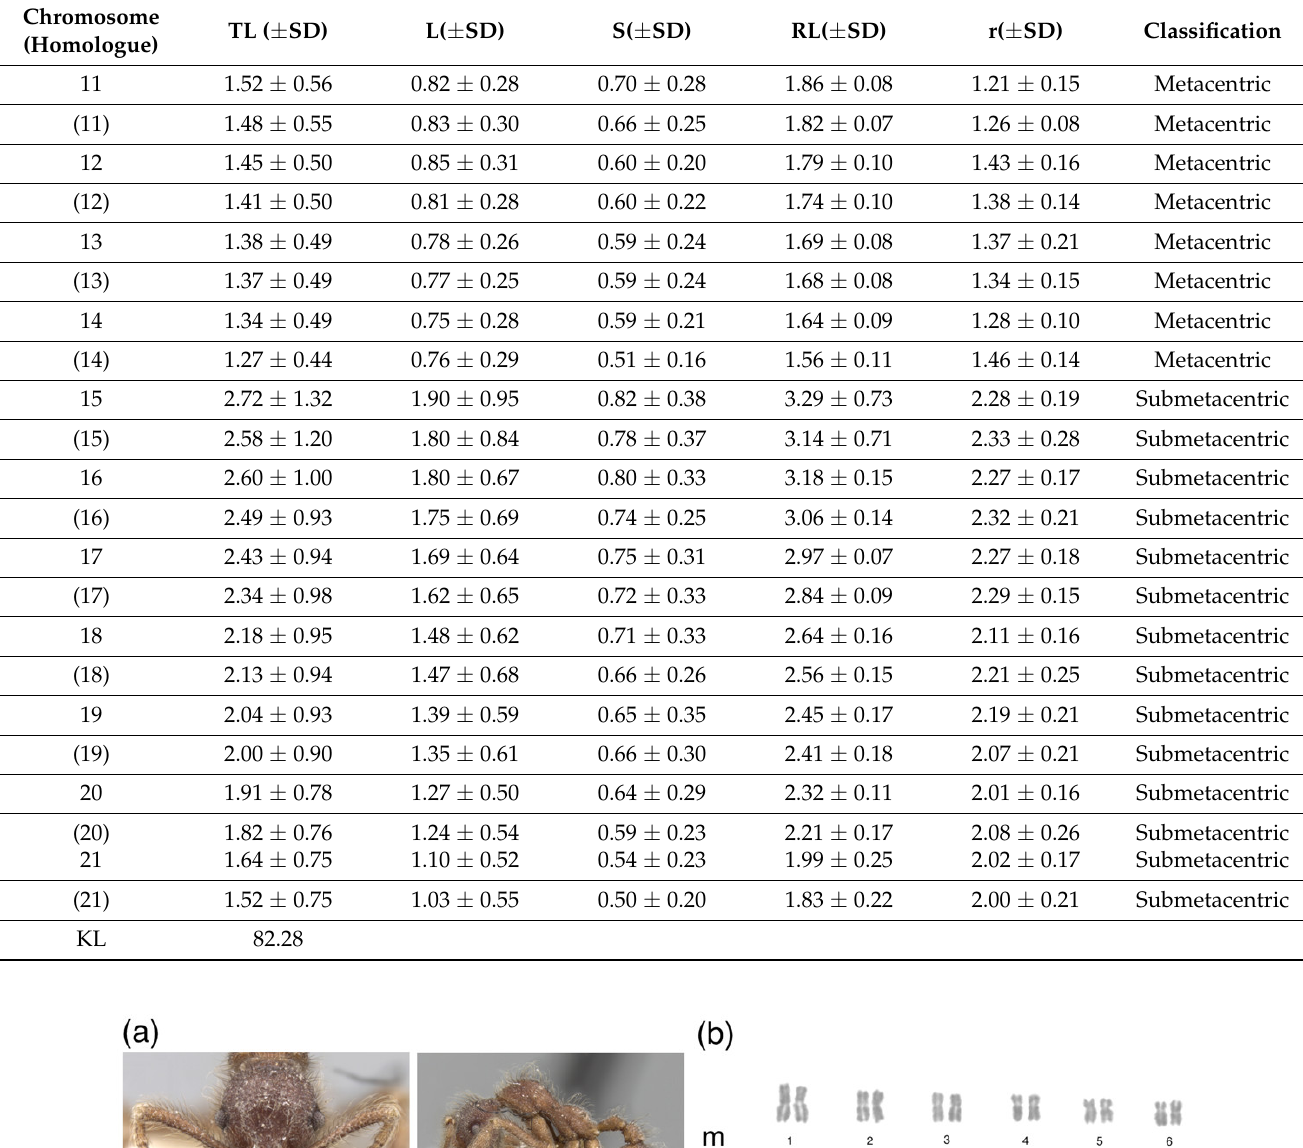
Figure 4. Mitotic chromosomes of Apterostigma madidiense stained with Giemsa. Species ( a ) images and ( b ) diploid karyotype of Apterostigma madidiense with 2 n = 24 chromosomes. m = metacentric. Scale bar = 5 µ m. Ant image from AntWeb (www.antweb.org, accessed on 13 June 2021): Apterostigma madidiense (CASENT0281778, photo by: S. Hartman). Table 4. Karyomorphometric analyses of the chromosomes of Apterostigma madidiense . All measurements are given in “µm”. TL: total length; L: long arm length; S: short arm length; RL: relative length; r: arm ratio; KL: karyotype length.